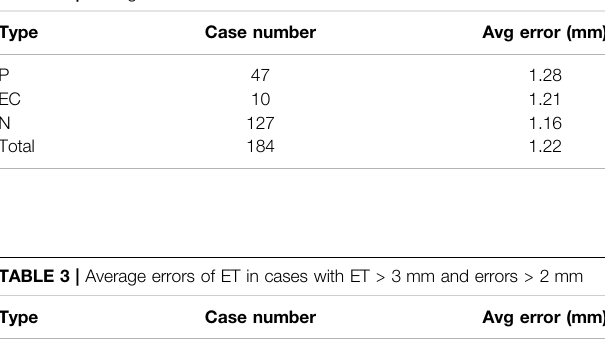
TABLE 2 | Average ET measurement errors in cases with errors ≤ 2 mm